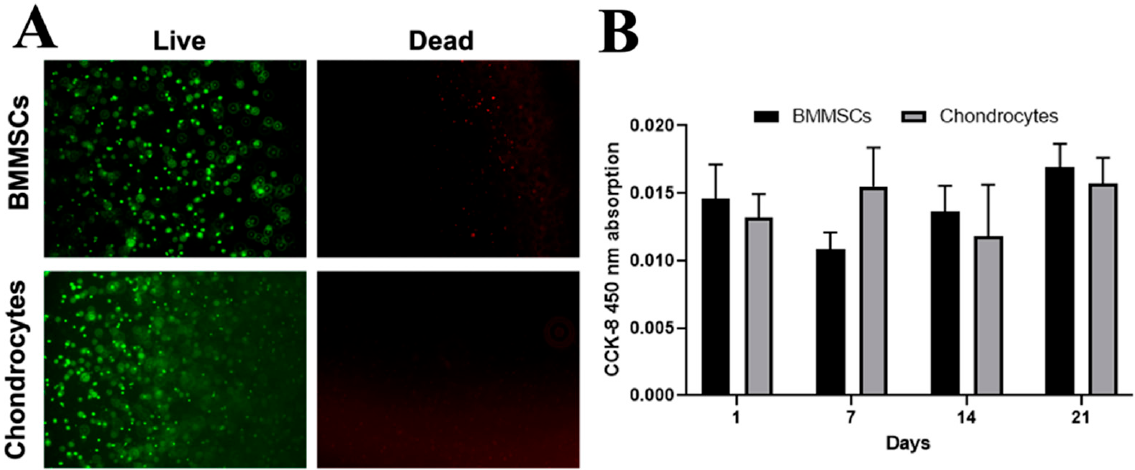
Figure 5. The viability of BMMSCs and chondrocytes in CS-Tyr/Gel hydrogels subjected to the chon- drogenic differentiation for 1, 7 and 14 days. ( A ) The fluorescent micrographs of the encapsulated cells using Live/Dead kit: Calcein-AM shows viable cells (green fluorescence), while propidium io- dide identifies dead cells (red fluorescence) after 21 days in chondrogenic differentiation medium; magnification: ×40. ( B ) The metabolic cell activity measurement using commercial CCK-8 kit (cell medium absorption was spectrophotometrically measured at 450 nm). Data are shown as mean ± SD, n = 3 from not less than three different cell cultures of each type.